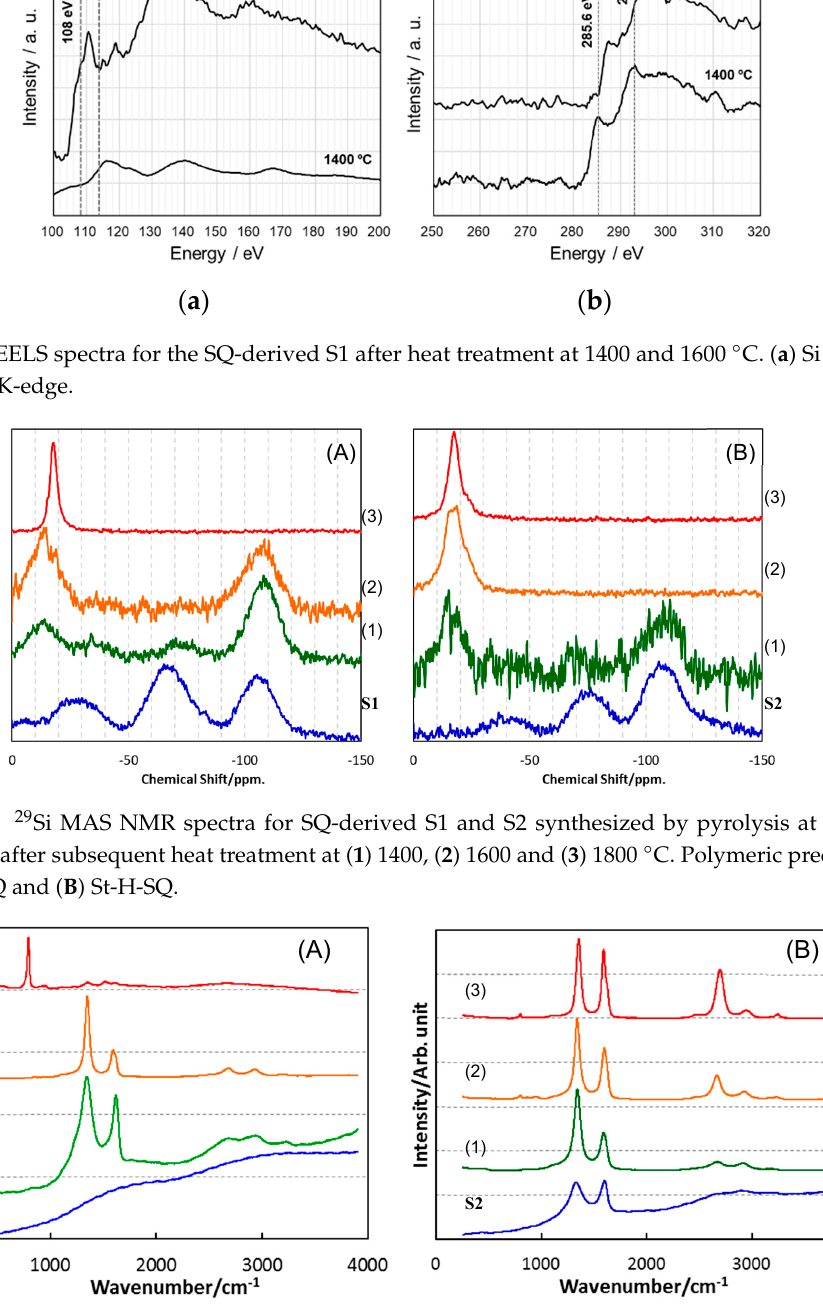
Figure 11. Raman spectra for SQ-derived S1 and S2 synthesized by pyrolysis at 800 °C, and those after subsequent heat treatment at ( 1 ) 1400, ( 2 ) 1600 and ( 3 ) 1800 °C. Polymeric precursors: ( A ) VH-SQ and ( B ) St-H-SQ.